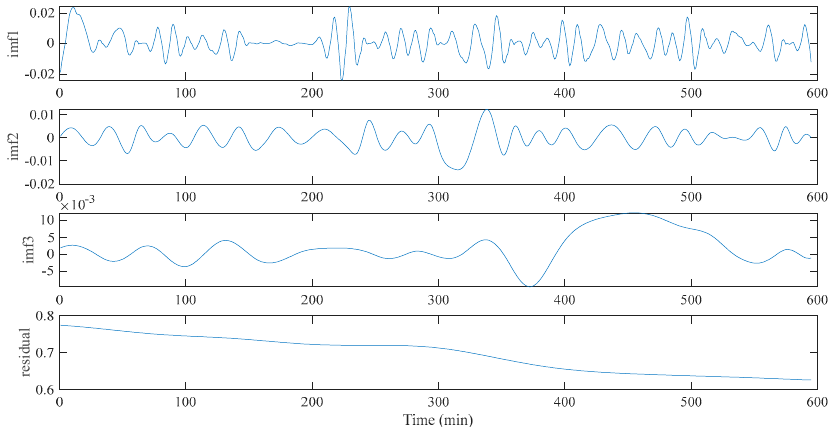
Figure 4. EMD decomposition of ash accumulation curve.